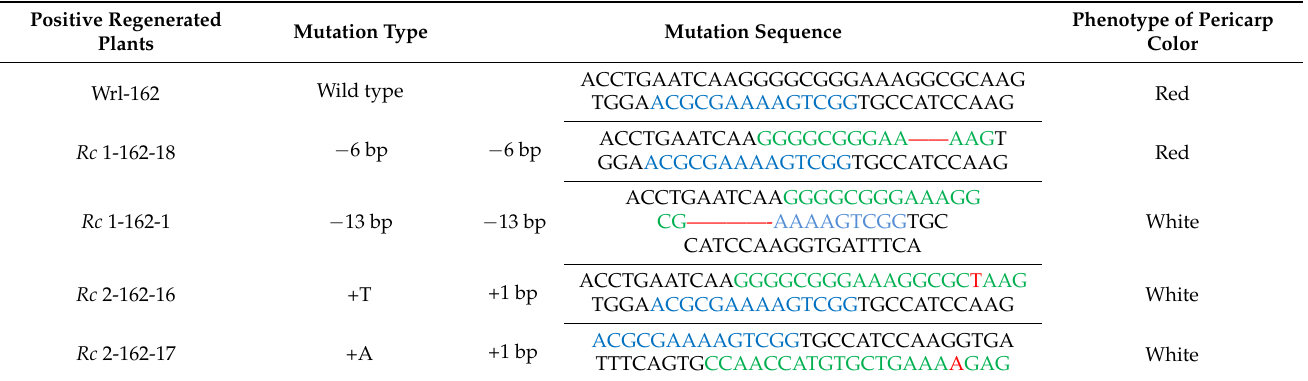
Figure 1. Molecular identi fi cation of T1 plantlets for weedy rice. Note: Hpt (Hygromycin gene), Cas9 (Cas9 gene) and UBI (promotor sequence) are all located on the pREGB32 vector. In ( a – c ), Hpt, Cas9 and UBI was detectd respectively. M was Marker. “+” was pREGB32 vector as positive control. “ − ” was water as negative control. 1–22 were T1 generation plants, respectively. Primers in Supplementary Table S1. Table 1. Pericarp color and Rc genotype of T1–T3 generation plantlets for weedy rice (Field No. 162).